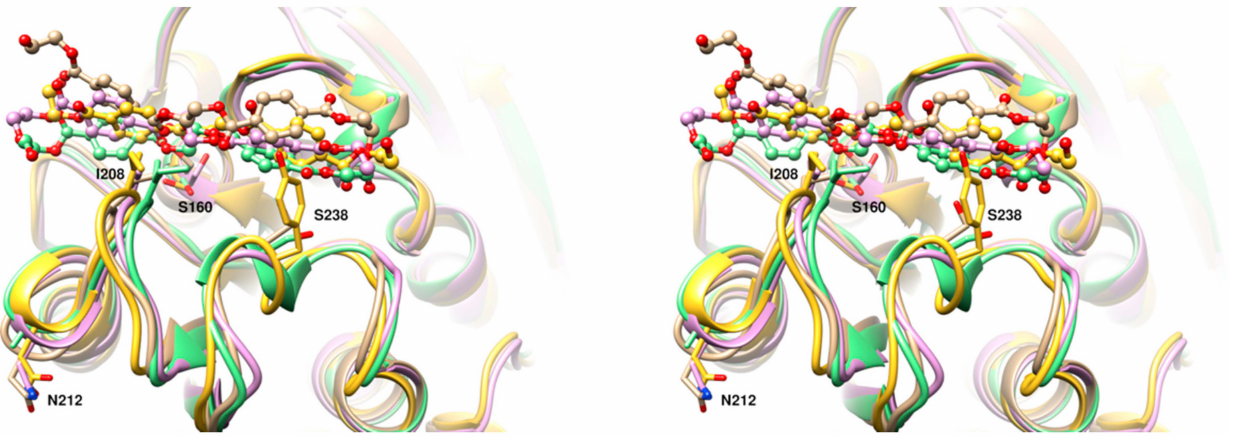
Figure 6. Stereoview of the superposition of Is PETase WT (tan) and the mutant variants, I208V (magenta), N212A (green), and S238Y (yellow) with PET bound. PET is represented as balls and sticks, while the mutated residues are depicted as sticks models. The catalytic residue S160 is also